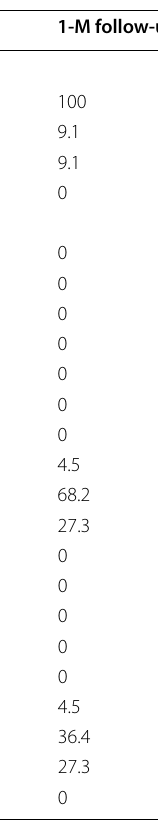
Table 2 CT findings of the 11 patients at three time points